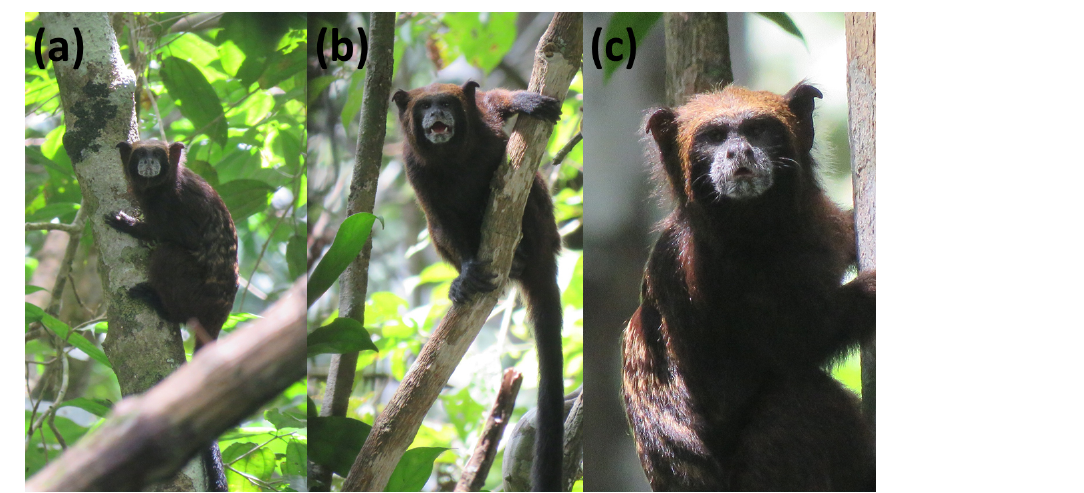
Figure 2. Adult Leontocebus fuscicollis fuscicollis . Note the brown forehead and the light brown line above the eyebrows and at the sideburns that are typical for this taxon. Panels (a) and (b) show the same individual (photos: Elvis Charpentier). (c) Photo: Gabriel García-Mendoza.